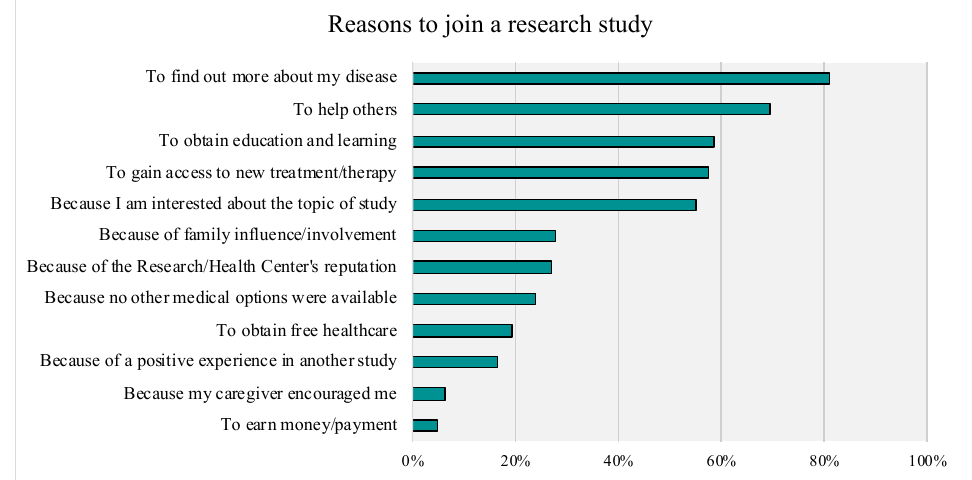
Figure 4. Rankings of Reasons for Joining a Research Study. Top Box Responses (“very important”) are Presented.